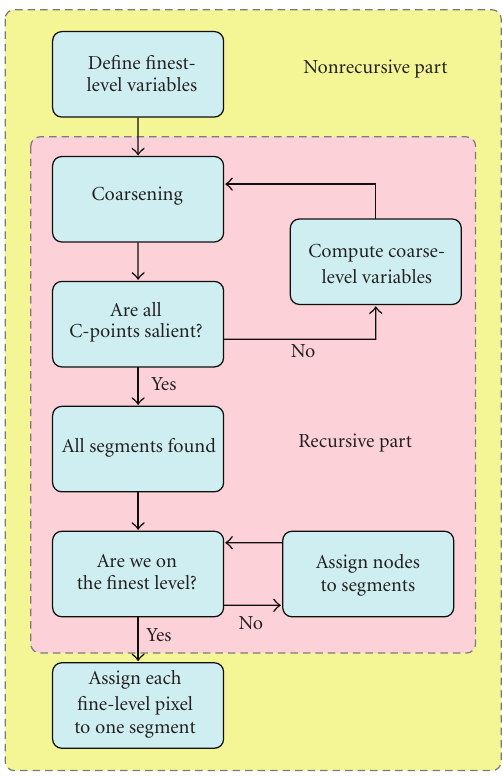
Figure 3: Flow chart for the algorithm with the recursive and nonrecursive